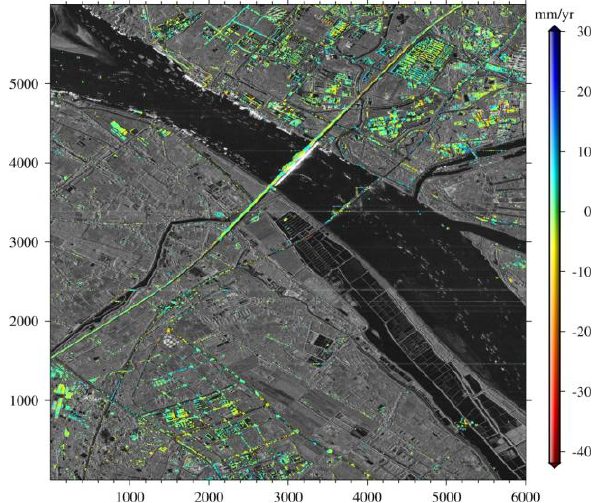
Figure 3. Deformation rates of the study area